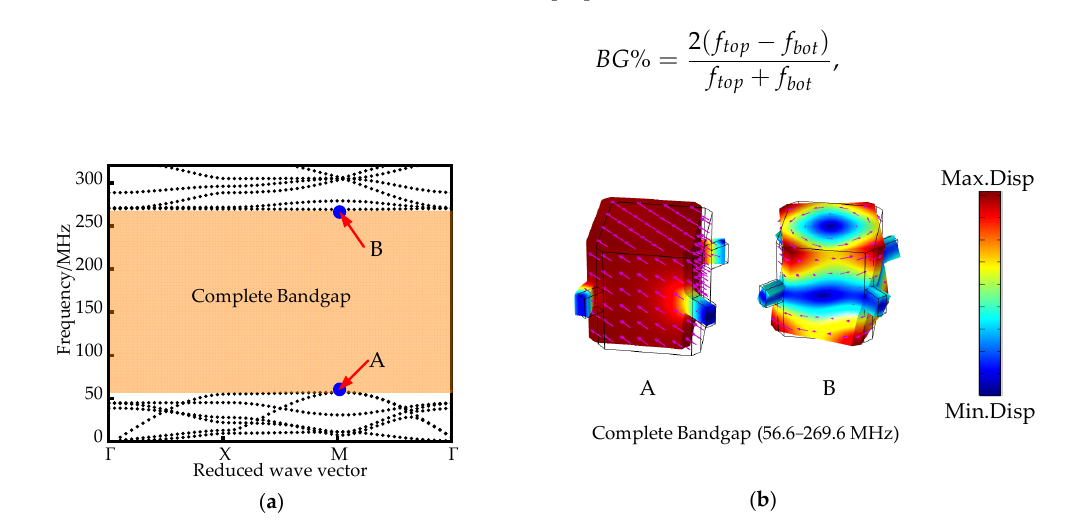
Figure 2. ( a ) SCC ‐ PnC dispersion curve ( b ) Vibration mode diagram at the start and end points of the band gap (The arrow represents the size and direction of the displacement).